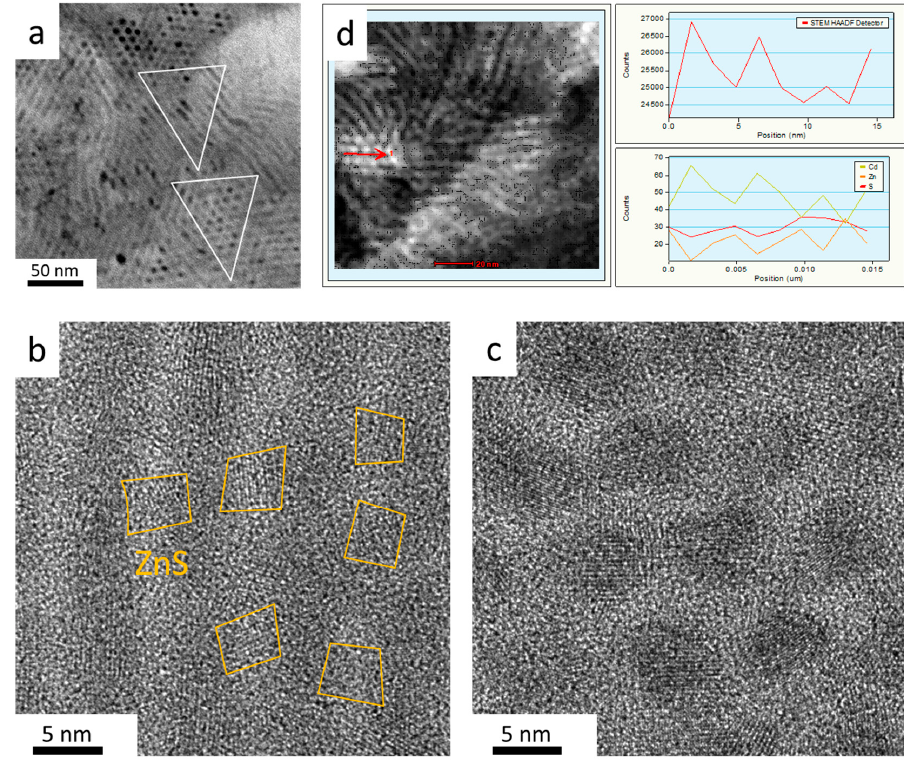
Figure 2. ( a ) TEM and HRTEM images of the side ( b ) and top ( c ) view of the CdSe/CdS/ZnS QRAs. ( d ) HAADF element analysis of the QRAs in the selected line.